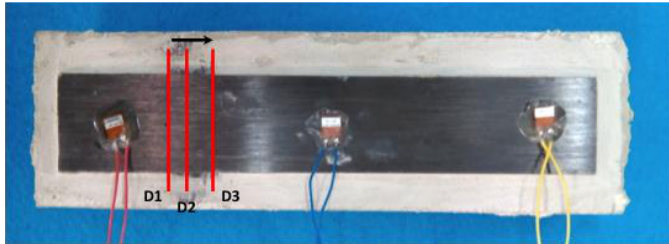
Figure 10. FRP-strengthened concrete specimen with three PZT transducers.